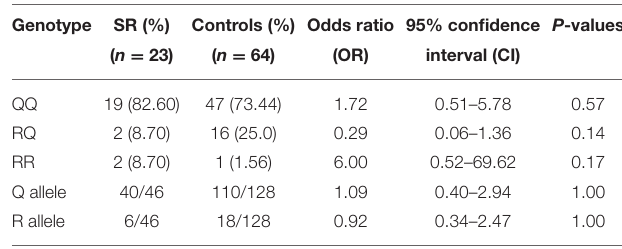
TABLE 5 | Comparison of IL-13 gene polymorphism genotype and allele frequencies between steroid sensitive (SS) and steroid resistant (SR) Kuwaiti INS patients.